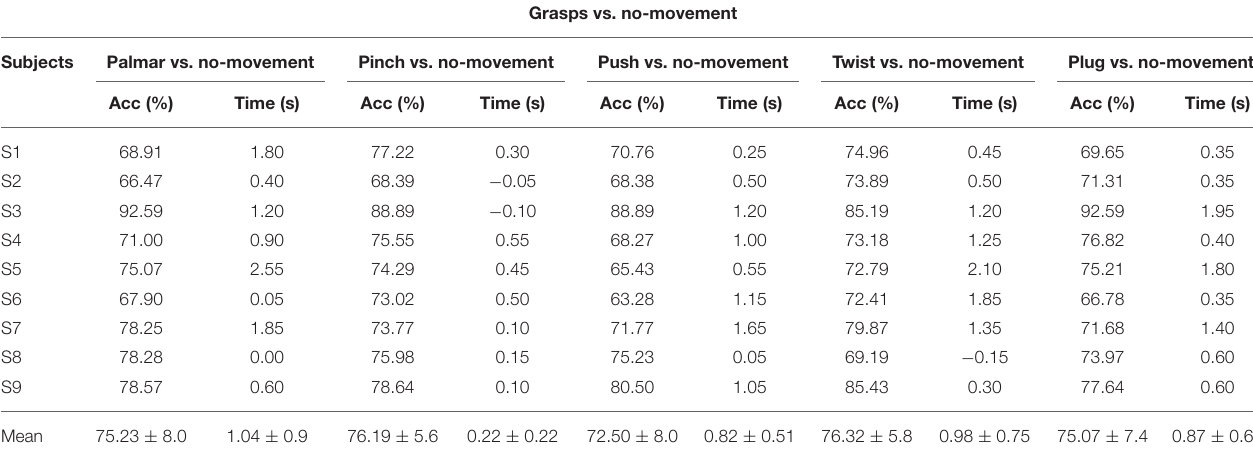
Grasps vs. no-movement